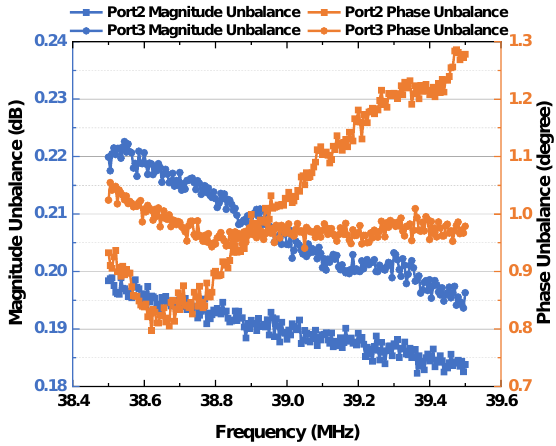
Figure 11. Measurement results of magnitude unbalance and phase unbalance of new feeding net- work.